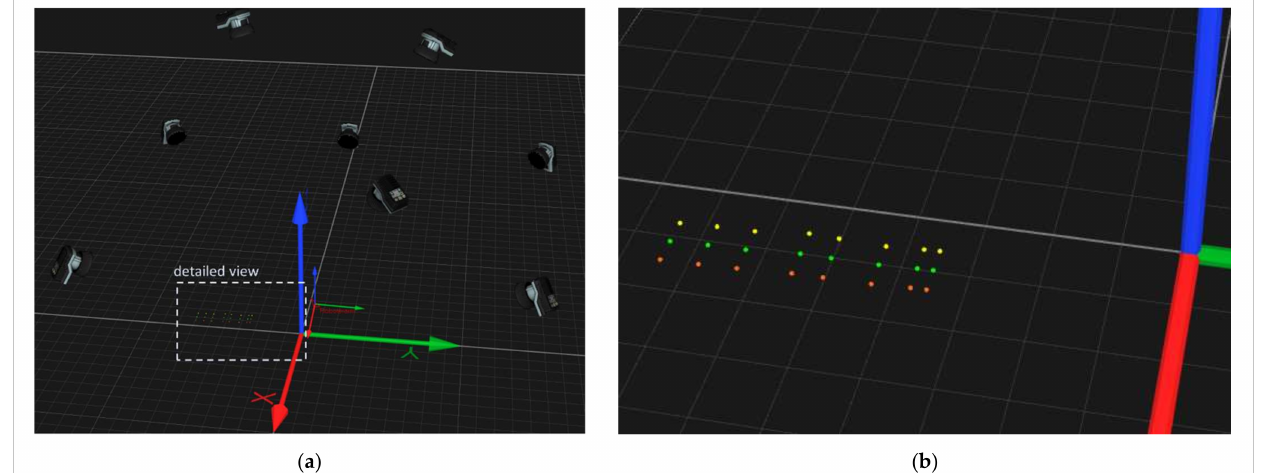
Figure 3. ( a ) Illustration of the experimental setup based on Qualisys Tracker Manager Software. Eight infrared cameras detecting the passive markers. The large reference coordinate system is stationary and the robotic arm coordinate system moves in space together with the instrumented infrared markers on the calibration profile. ( b ) Detailed view: The infrared markers are labeled with different colors, each color corresponding to a specific curvature (orange: 0.1 yellow 0.4 m − 1 ). Within a color, additional distinctions are made with respect to marker distances (50 mm, 110 mm, and 170